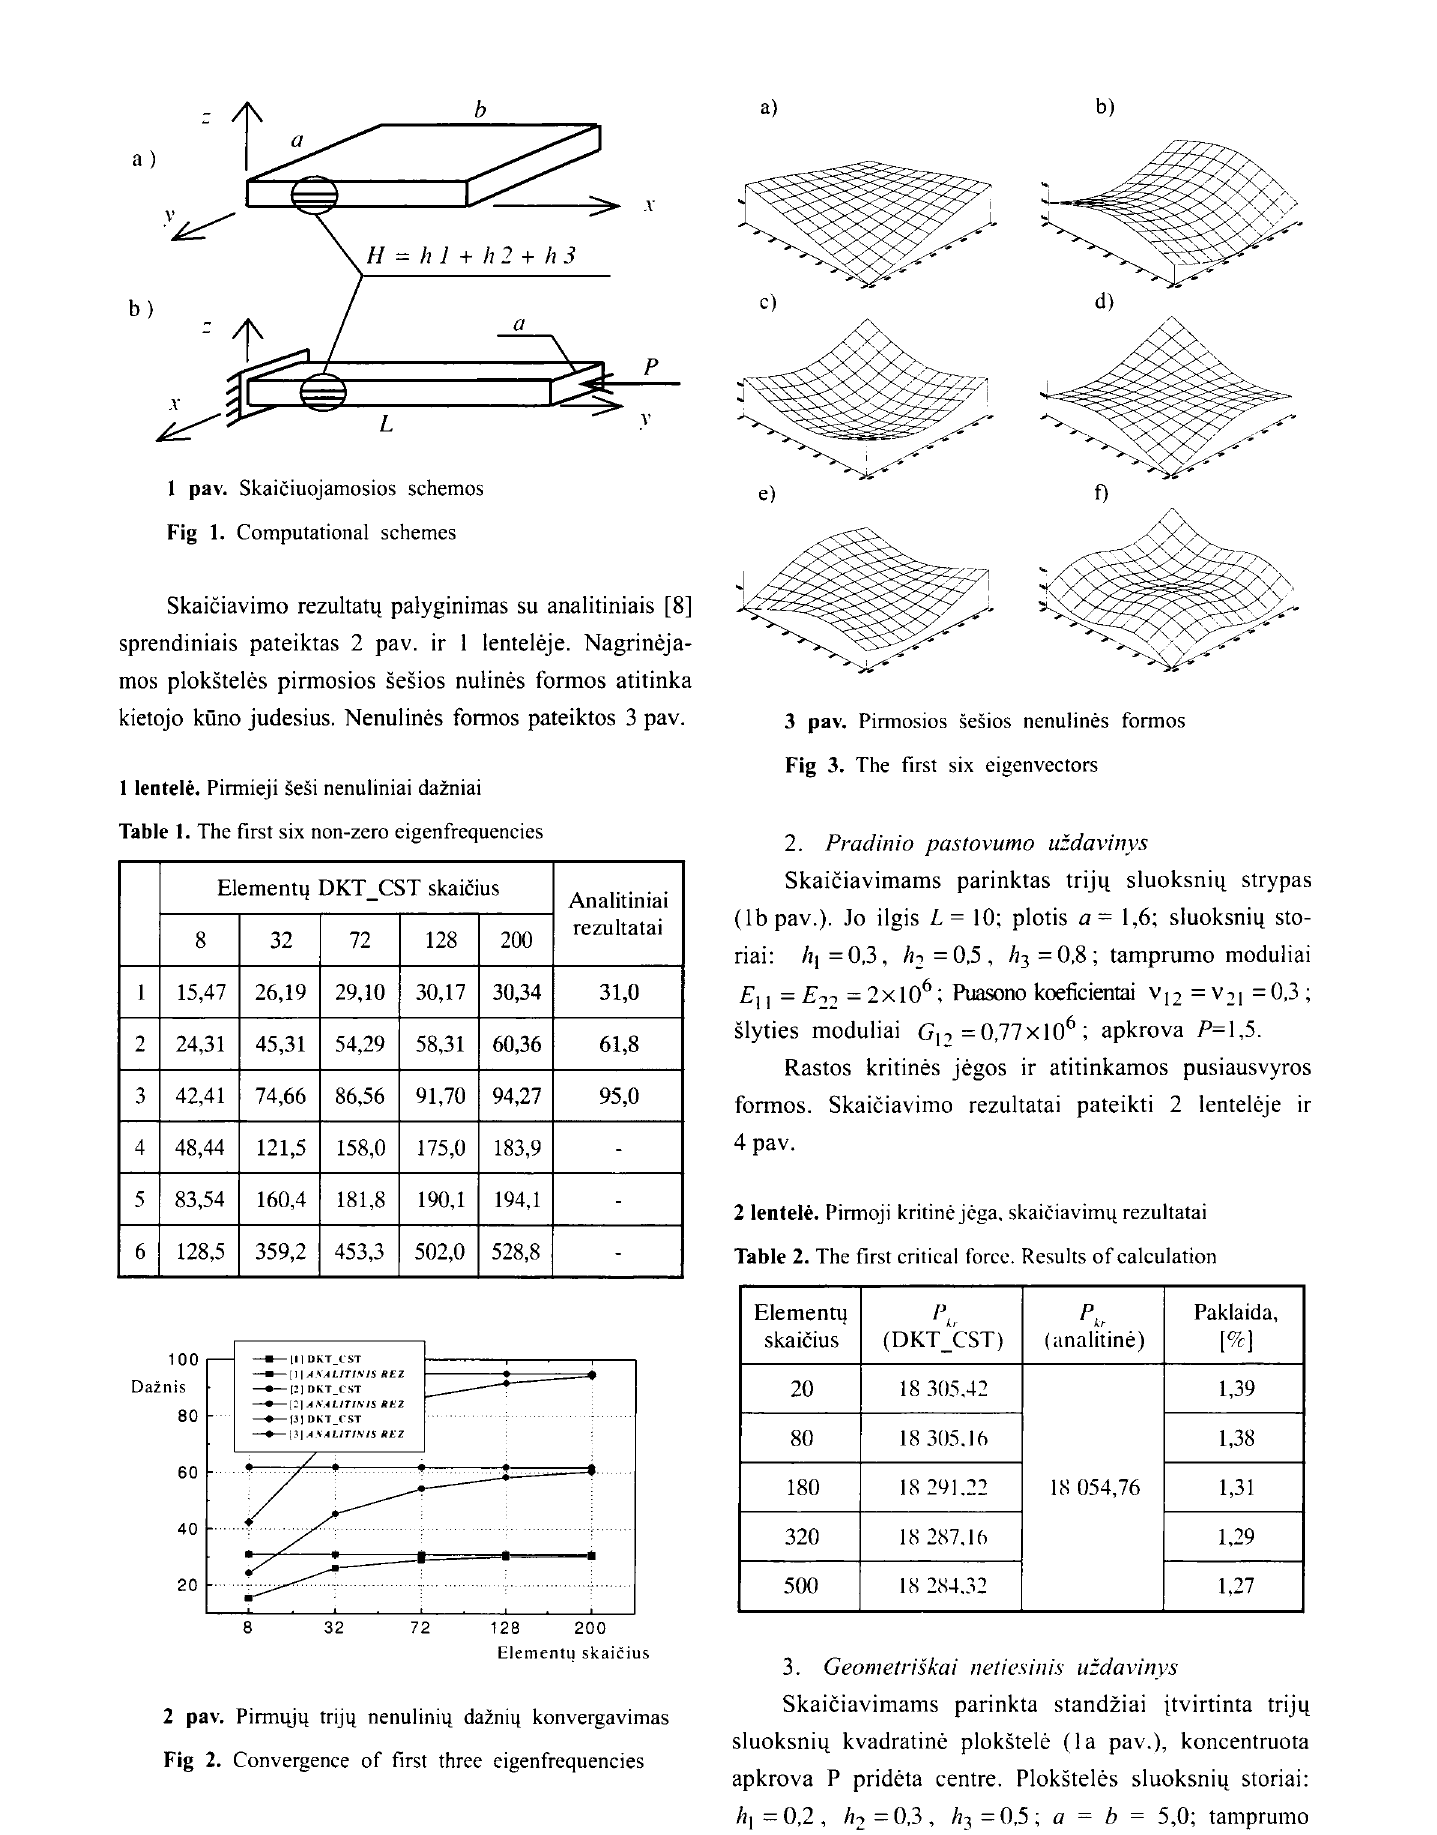
Fig 1. Computational schemes